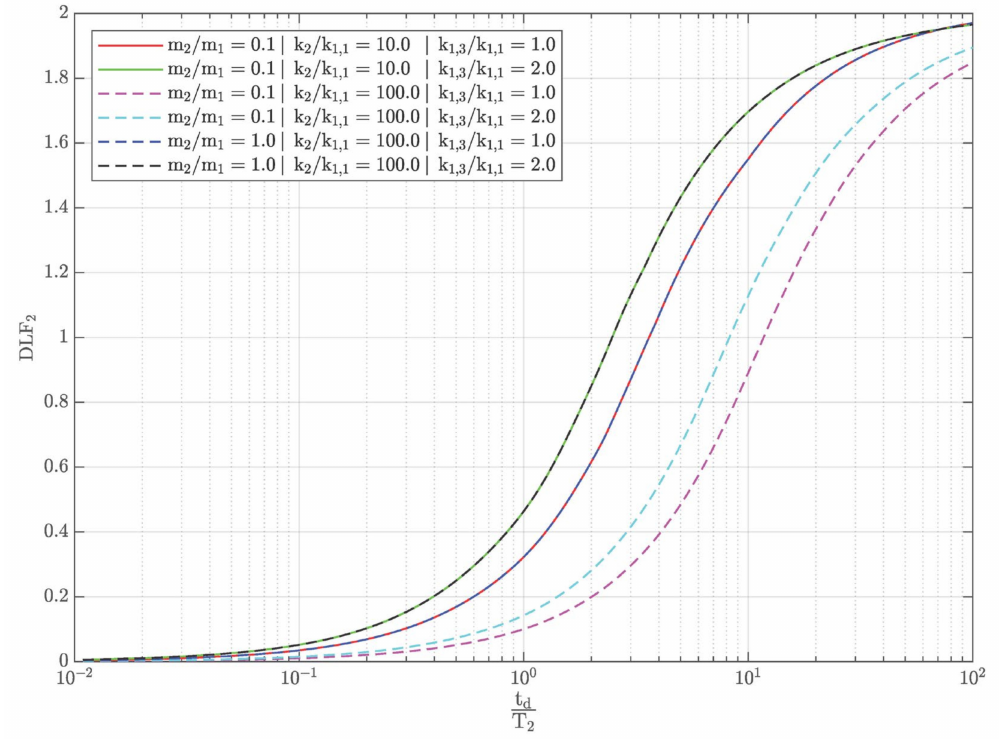
Figure 7. DLF 2 of supporting structure when cladding is considered to be a membrane structure with k 1,3 / k 1,1 = 1.0, 2.0 at mass ratios m 2 / m 1 = 0.1, 1.0 and bending stiffness ratios k 2 / k 1,1 = 10.0,